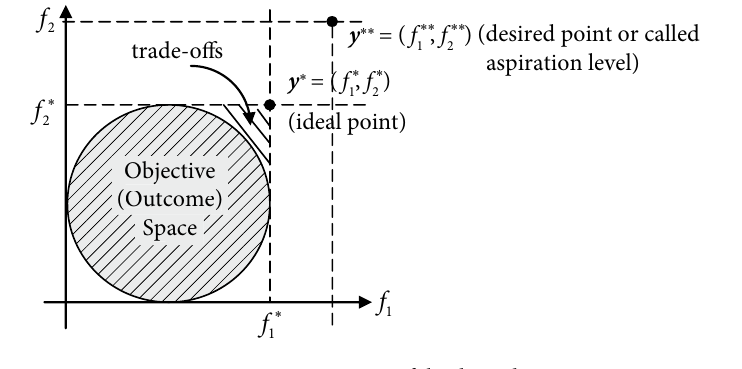
Fig. 2. Basic concept of the desired